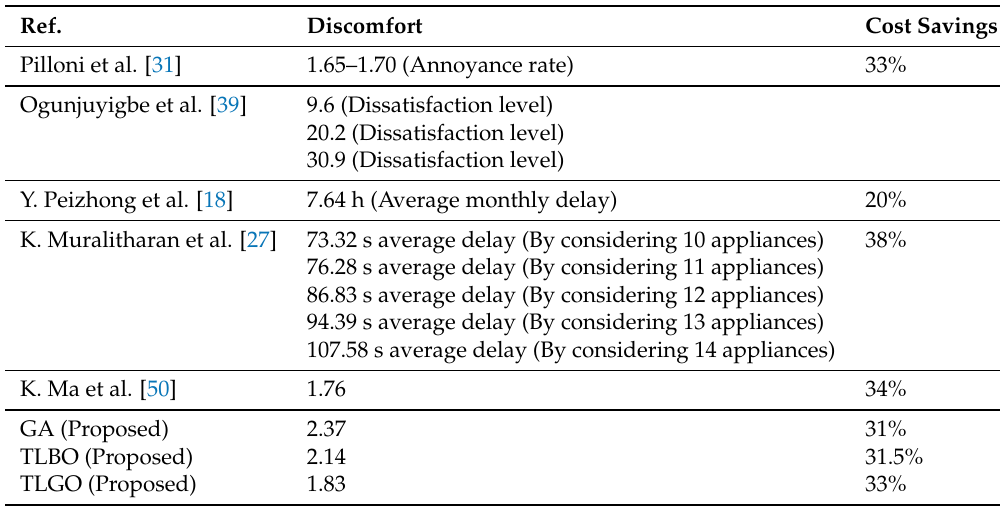
Figure 3. Appliances schedule with DAP for 1 h time slot. Table 5. Comparison with